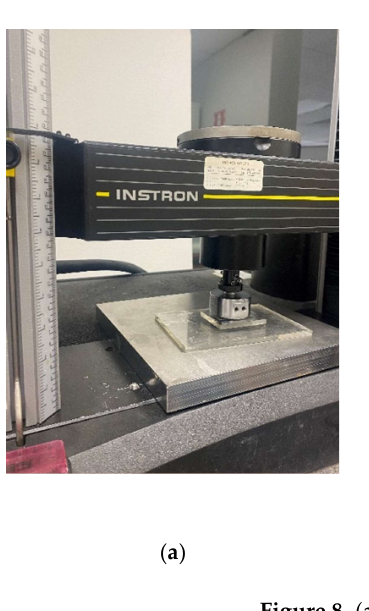
Figure 8. ( a ) Instron machine 5866 used to conduct the compression stress, and the obtained ( b ) compression stress and versus compression strain plot.